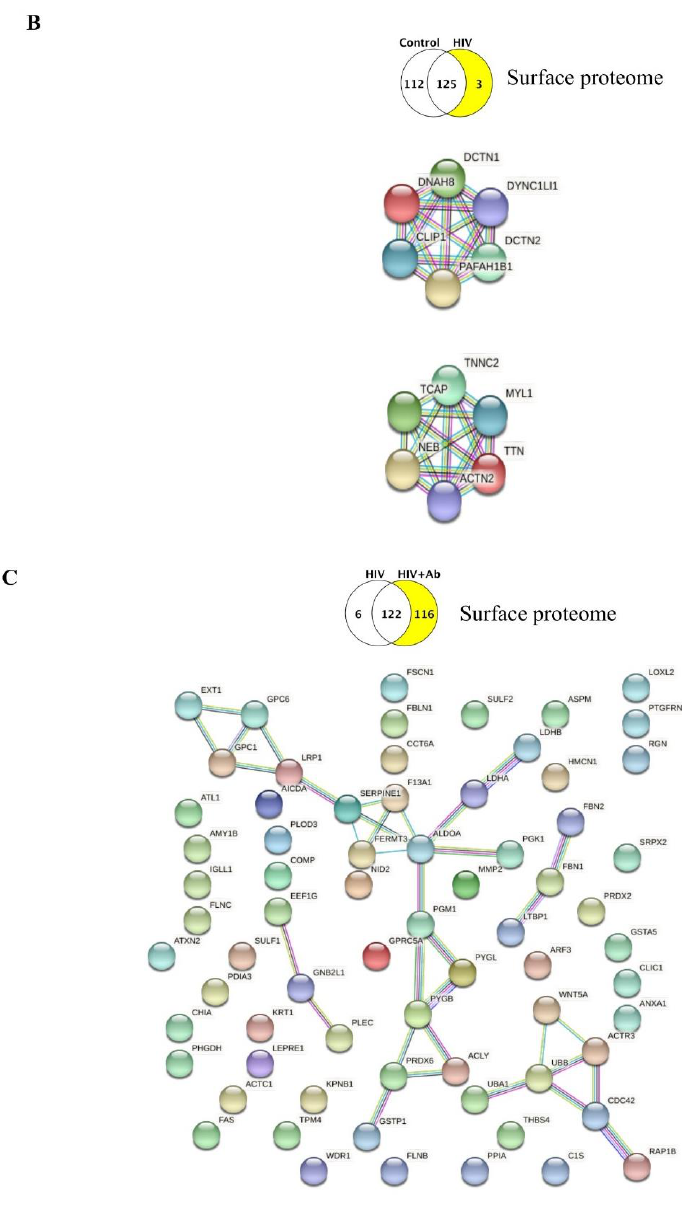
Figure 3. Protein–protein interactions between the identified unique proteins of the EV surface proteome. Venn diagrams illustrating the type of comparison and the number of identified unique proteins (highlighted). ( A ) Protein–protein interactions (PPI) (STRING) among the unique surface proteins in the control group. Only interactions with the highest confidence are shown with a minimum required interaction score of 0.900 (PPI enrichment p-value: 6.59 × 10 − 7 ; the network has significantly more interactions than expected). Known interactions: From curated databases (turquoise), experimentally determined (pink); predicted interactions: Gene neighborhood (green), gene fusions (red), gene co-occurrence (blue); other interactions: Textmining (light green), co-expression (black), protein homology (purple). ( B ) No interactions with highest confidence were identified in STRING among the three unique proteins identified in the HIV group. Predicted functional partners of dynein heavy chain 8, axonemal (DNAH8) (upper map) and titin (TTN) (lower map). Only the first shell of five interactions with the highest confidence is shown. Color code of the interaction lines as described in ( A ). ( C ) Protein–protein interactions among the unique proteins in the HIV + A β group. Only interactions with the highest confidence are shown (PPI enrichment p-value: 0.00158; the network has significantly more interactions than expected). Color code of the interaction lines as described in ( A